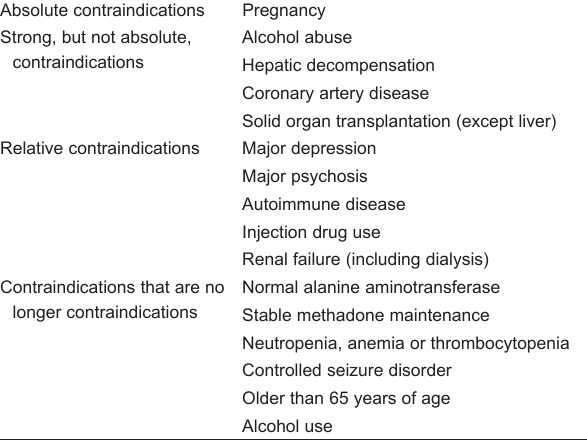
TABle 2 Contraindications for treatment with peginterferon